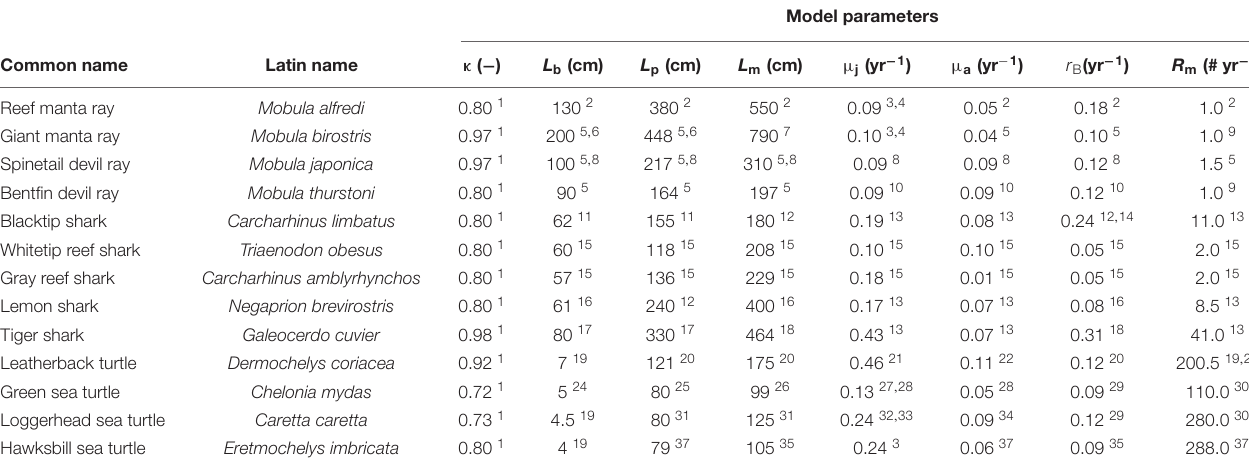
TABLE 2 | Model parameters for the mobulid, carcharhinid and cheloniid species.